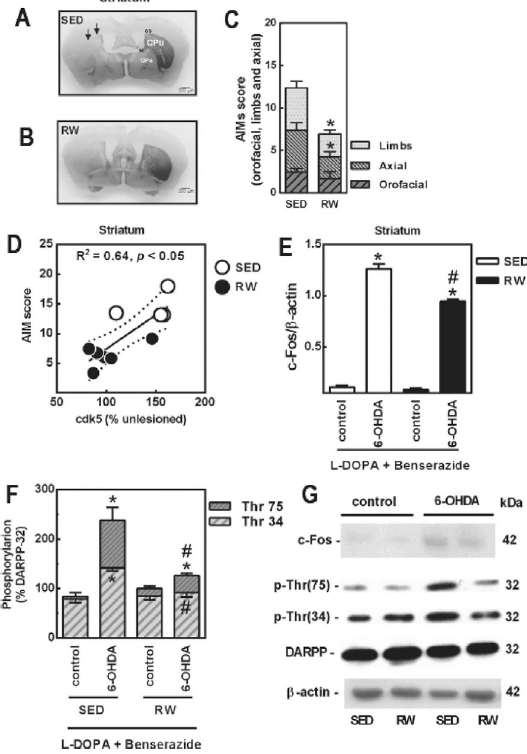
Figure 3 - Exercise and L-DOPA/Benserazide (25/12.5 mg/kg, i.p.) revealed no effect on neurodegeneration, evaluated as a decreased immu- noreactivity of tyrosine hydroxylase in the lesioned striatum (A, B); however, exercise was effective in reducing AIM (C). L-DOPA-induced dyskinesia's severity correlated with increased striatal levels of cdk5 (D) and c-Fos (E). L-DOPA also triggered hyperphosphorylation of DARPP- 32 at Thr(34) and Thr(75) sites in sedentary mice (F). Notably, exercise (RW) decreased these neurochemical changes typically associated with L-DOPA-induced dyskinesia. AIM, abnormal involuntary movements; cdk5, CPu, Caudate-putamen; GPe, external globus pallidus; cyclin- dependent kinase 5; DARPP-32, dopamine and cAMP-regulated phos- phoprotein 32 kDa; RW, running wheel; SED, sedentary; st, striatum terminals; Thr, threonine residue; 6-OHDA, 6-hydroxydopamine.